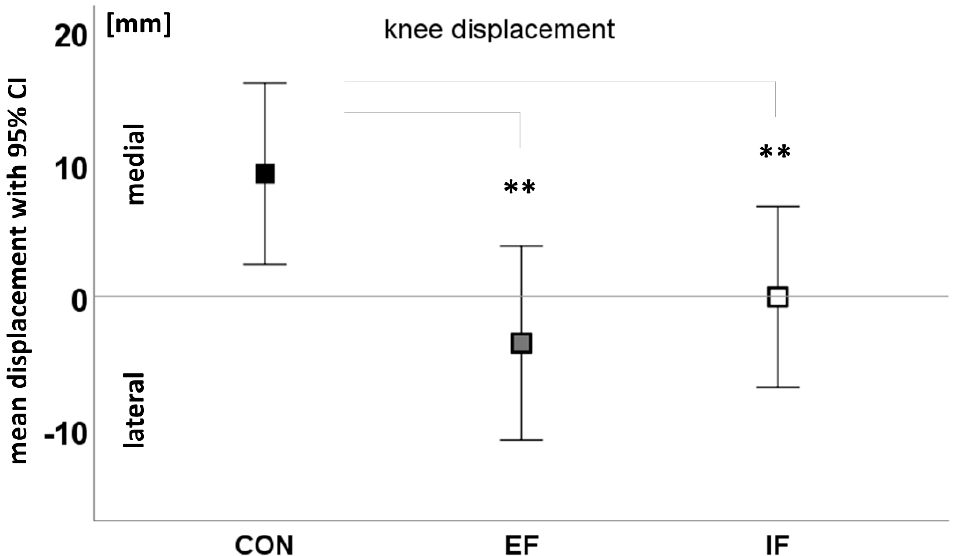
Figure 1. Main effect of focus on knee alignment (frontal displacement of knee-marker from first ground contact to deepest squat position) without instruction (CON) and with external focus (EF) and internal focus (IF) (** significant comparisons p < 0.01).